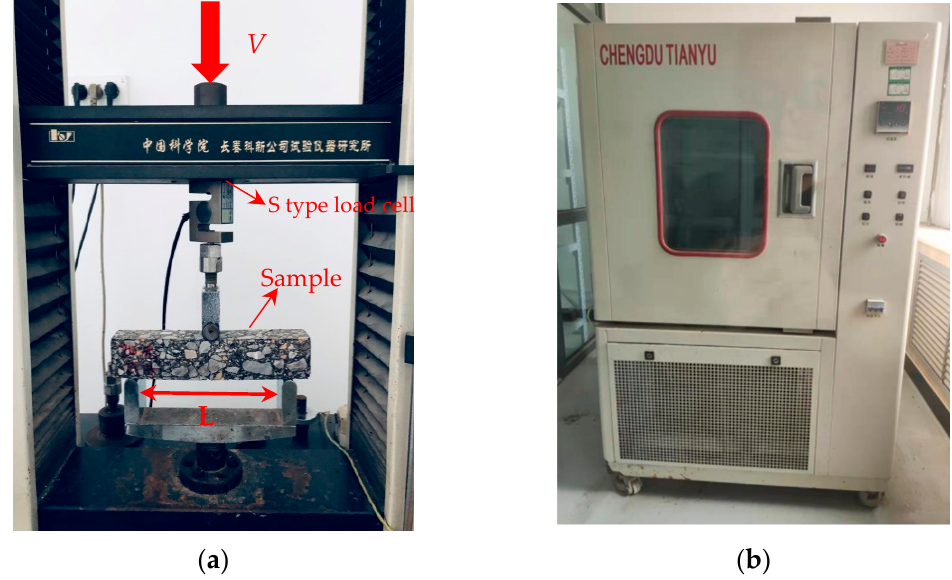
Figure 2. Test apparatuses. ( a ) The bending test apparatus; ( b ) temperature control box. Chinese in the figure: Changchun Kexin Company Test Instrument Research Institute, Chinese Academy of Sciences, Changchun, China.